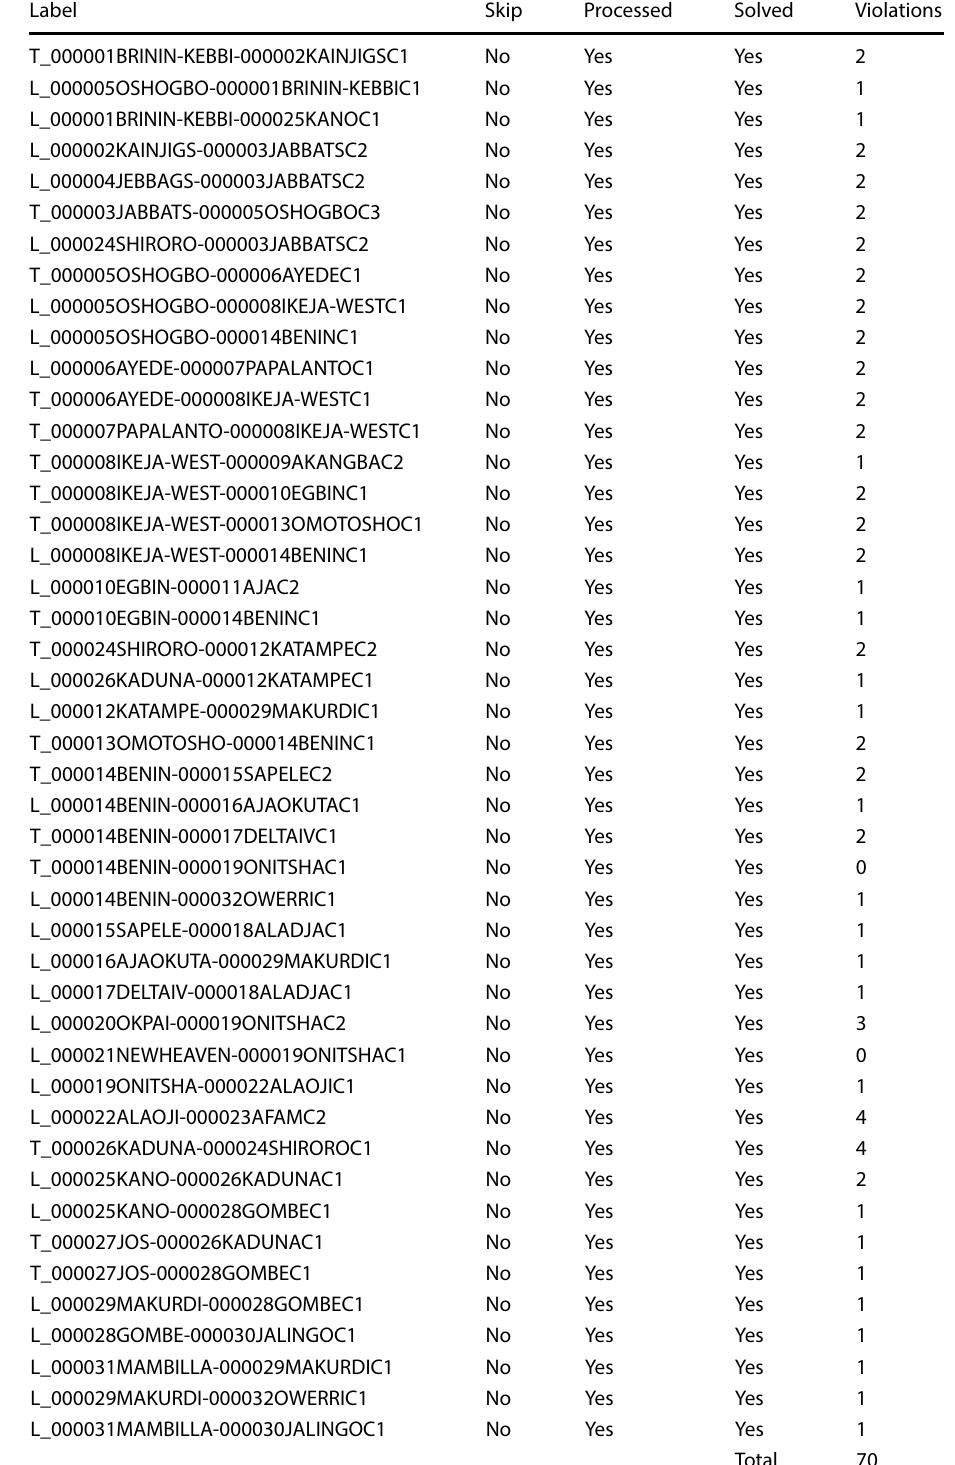
Table 5 Contingency records for integrated 750-kV super grid